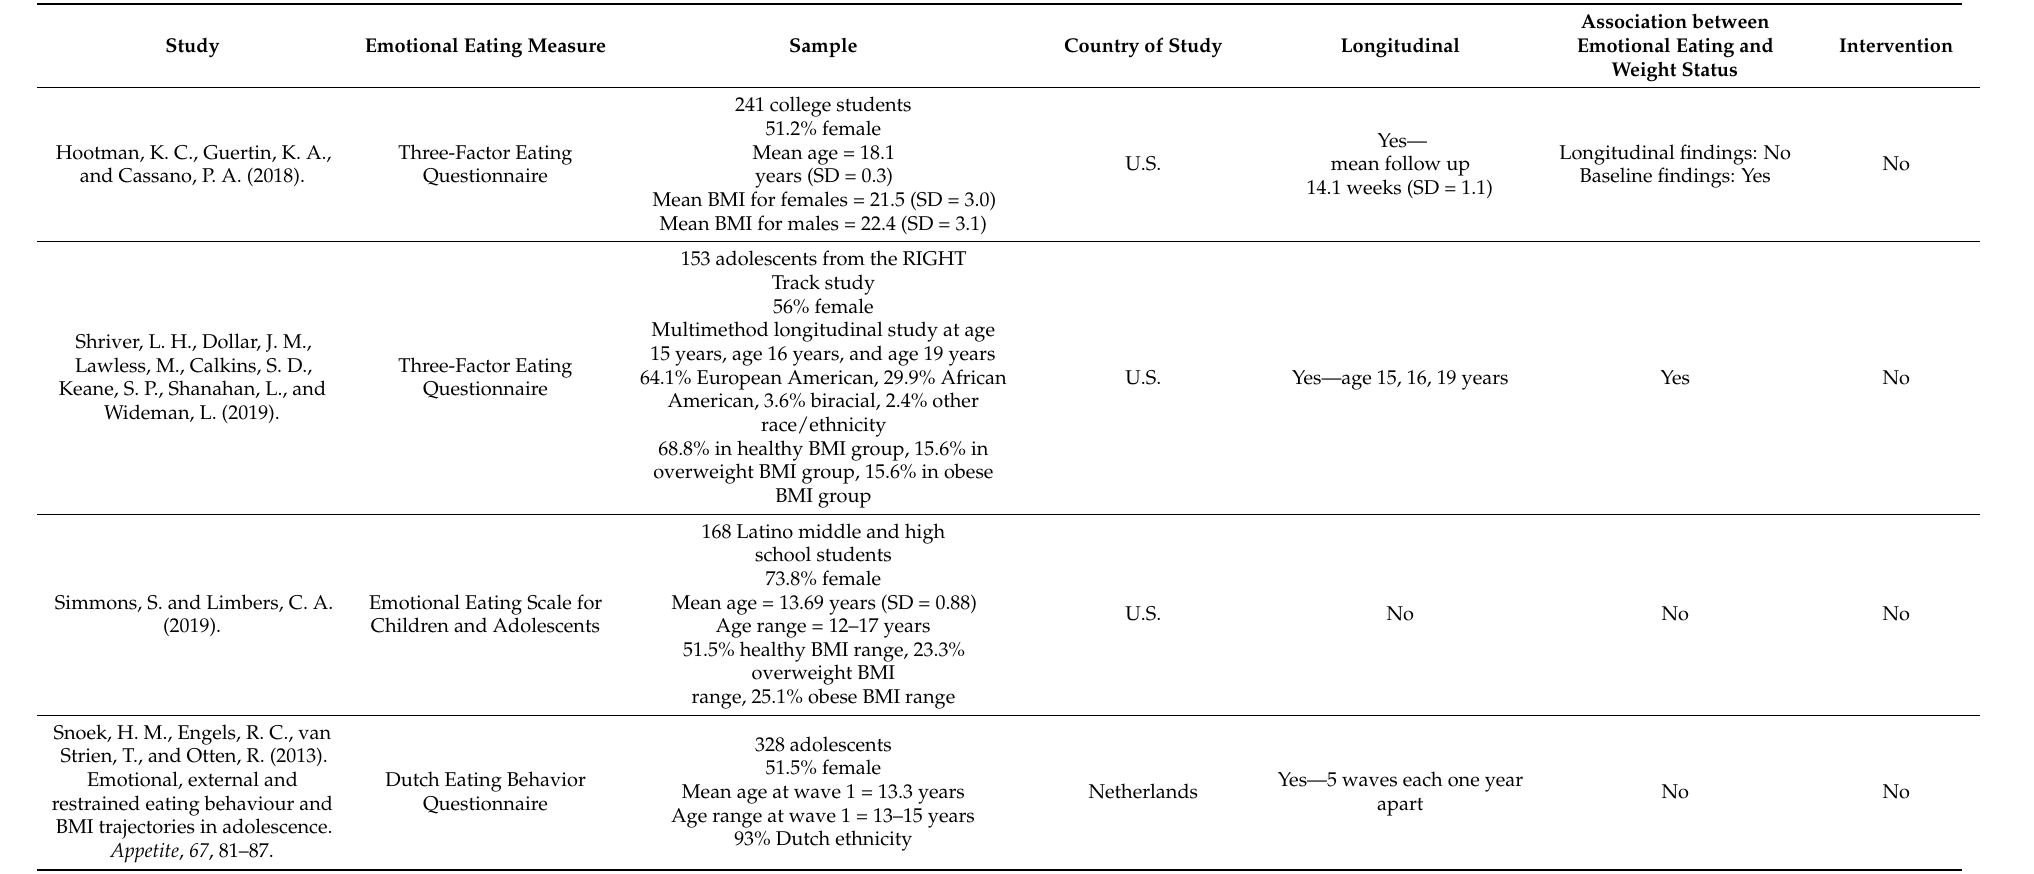
Table 1. Studies included in the systematic